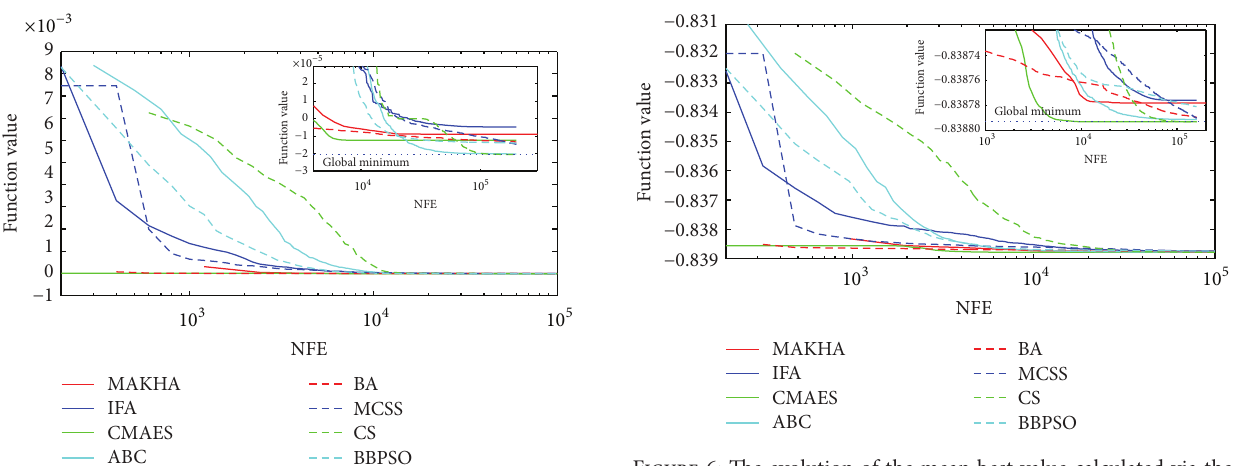
Figure 6: The evolution of the mean best value calculated via the eight metaheuristics versus NFE for problem G7.